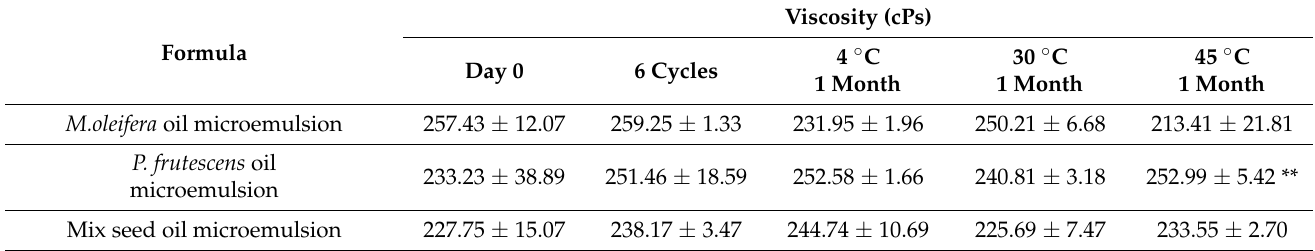
Figure 3. Flow curves of P. frutescens , M. oleifera , and mixed seed oil microemulsions measured at day 0 after storage at ( A ) six cycles of heating–cooling stability test. ( B ) 4 °C, ( C ) 30 °C, and ( D ) 45 °C, expressed as shear rate and applied shear stress. Flow curves of P. frutescens , M. oleifera , and mixed seed oil microemulsions at day 0 after storage at ( E ) six cycles of heating–cooling stability test ( F ) 4 °C, ( G ) 30 °C, and ( H ) 45 °C, expressed as viscosity and shear rate. Table 4. Viscosity values of P. frutescens , M. oleifera , and mixed seed oil microemulsions freshly prepared, tested for six heating–cooling cycles, and 1 month storage at 4 ◦ C, 30 ◦ C, and 45 ◦ C. ** indicates p <